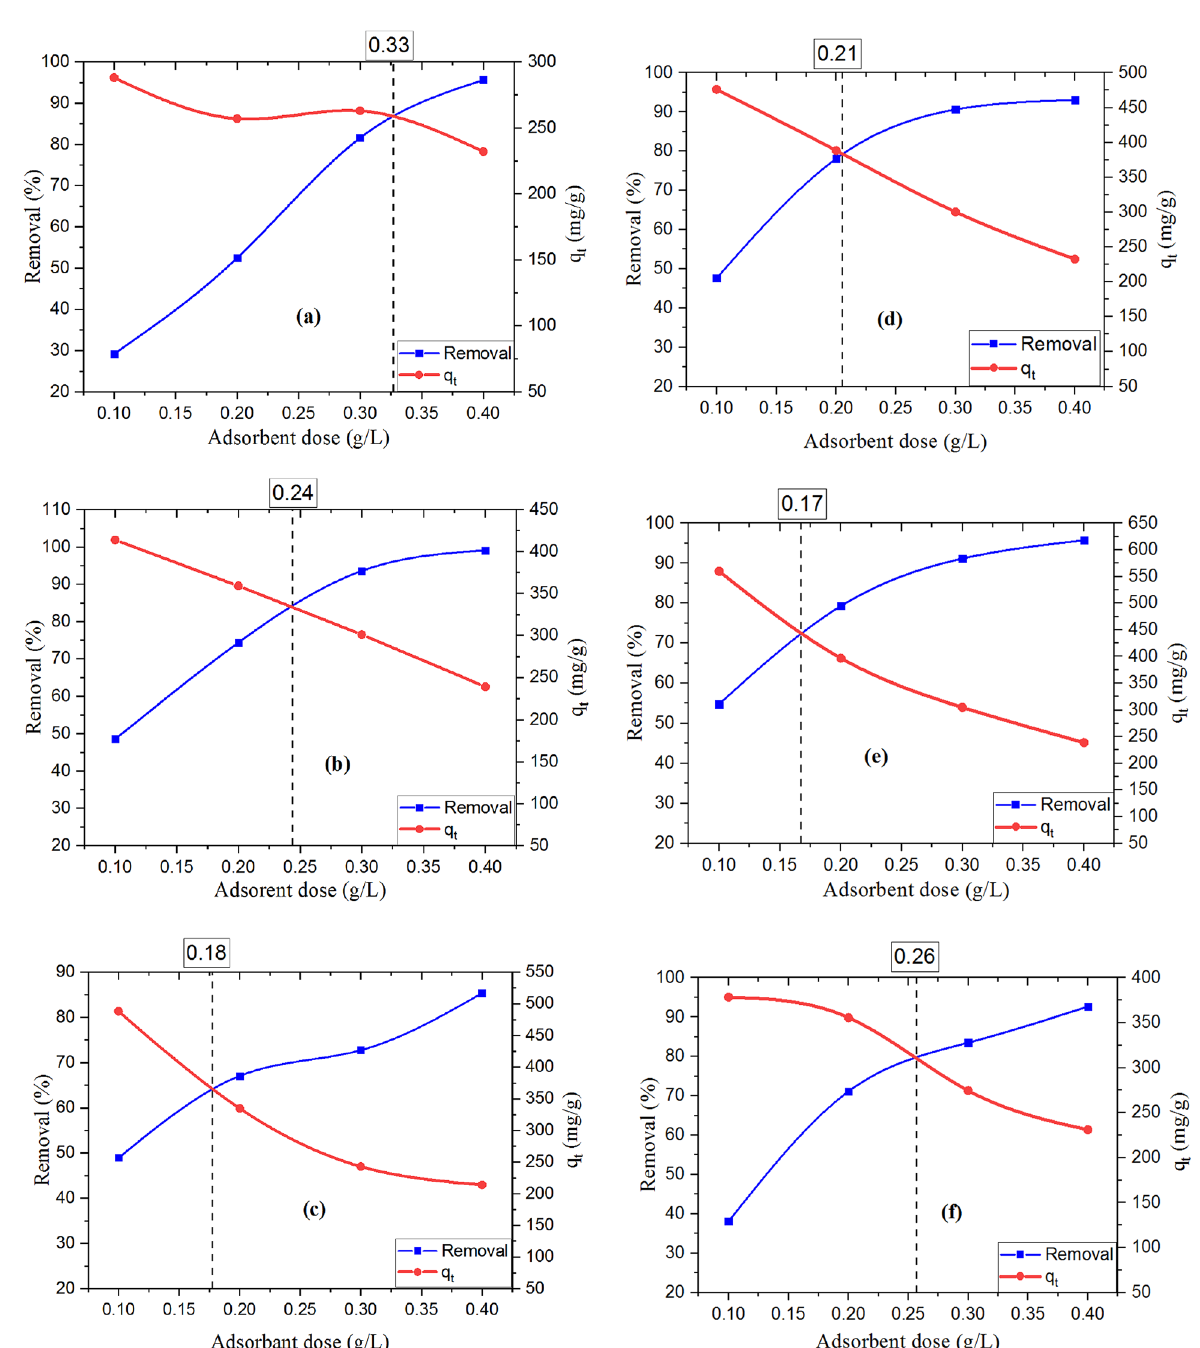
Figure 10. Effect of dose on the adsorption of TB onto ( a ) FGS1, ( b ) FGS2, and ( c ) FGS3, and on the adsorption of BPA onto ( d ) FGS1, ( e ) FGS2, and ( f ) FGS3 [pH: 3, initial concentration:100 ppm, agitation speed: 300 rpm, contact time 30 min, and temperature 25 °C].